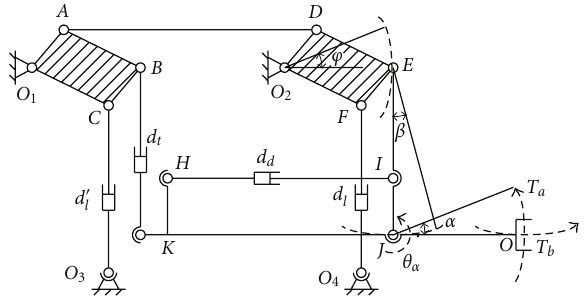
Figure 3: Geometric configuration of the major motion mecha-